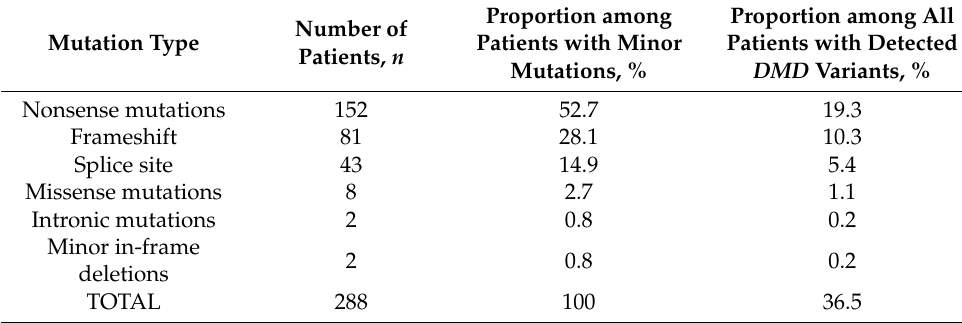
Table 1. Rates of minor mutations in the DMD